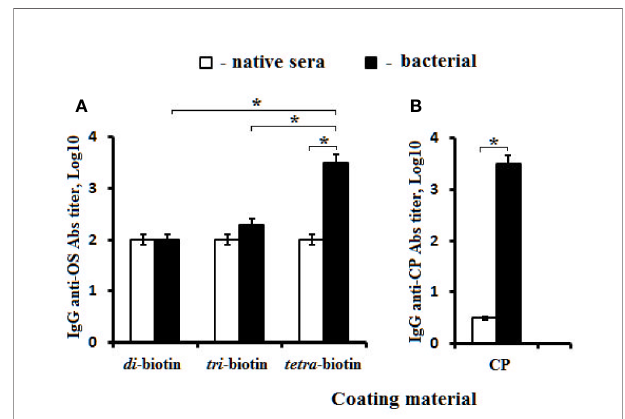
FIGURE 6 | Antibodies (Abs) in pooled rabbit (n = 2) antibacterial sera. (A) Biotinylated OS di – , tri – , and tetra – biotin applied as the coating antigens. (B) CP used as the coating material.Antibody titerswere transformedto log 10 (three assaysper antiserum). Data are displayed as a mean value ± SD.Mann – Whitney Rank Sumtests were usedto determine signi fi cance, * P < 0.05.